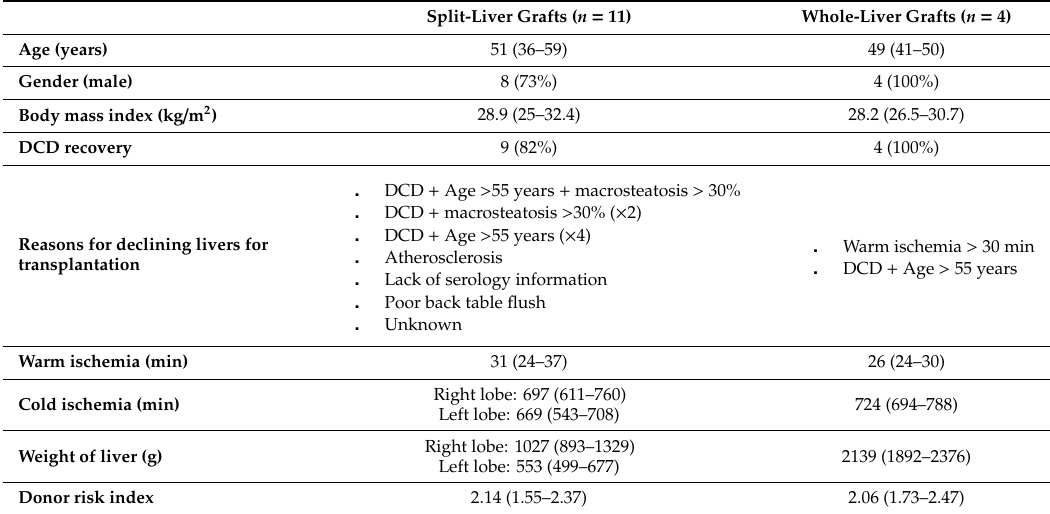
Table 1. Demographic data of discarded livers undergoing